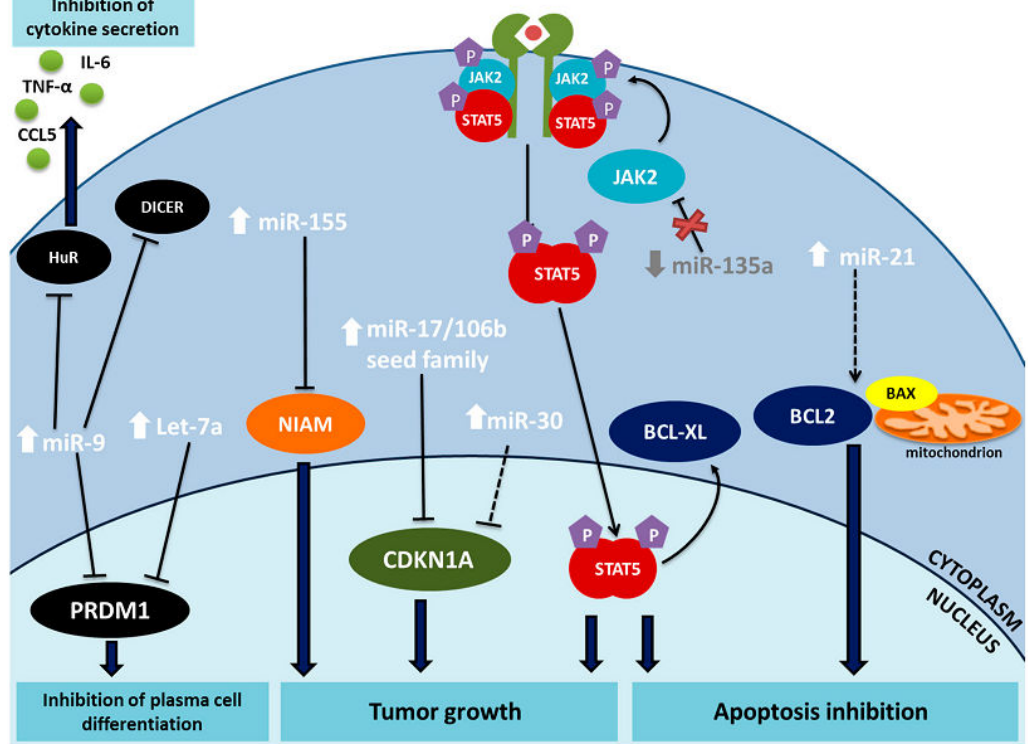
Figure 2. The main miRNAs involved in the pathogenesis of HL: miR-9, let-7a, miR-155, miR-17/106b seed family, miR-30, miR-135a, and miR-21. Arrows indicate the expression level of each miRNA in HL. Solid lines indicate validated regulation of the target gene, while broken lines indicate indirect regulation of the gene. Blue arrows lead from the gene to the final effect of the miRNA